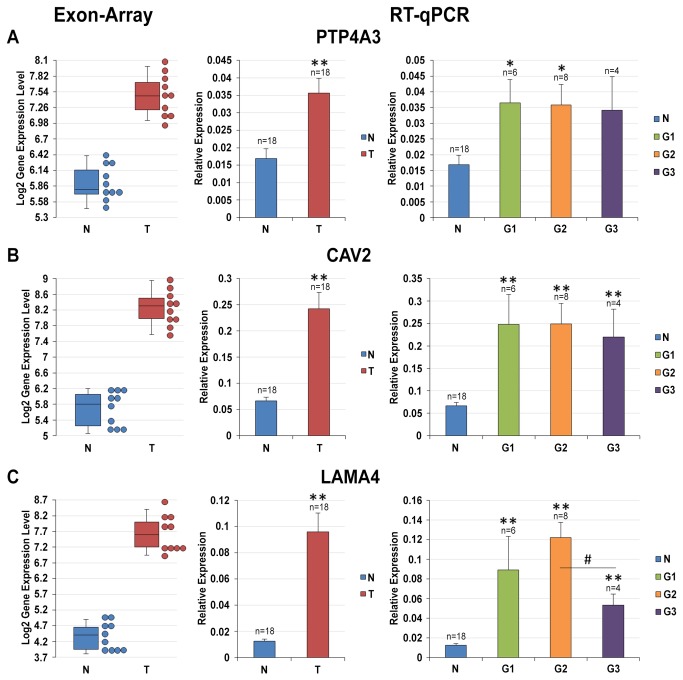
Gene Expression analysis of PTP4A3, CAV2 and LAMA4 genes.Expression levels of PTP4A3 (A), CAV2 (B) and LAMA4 (C) genes were calculated relative to the mean expression levels of ACTB and RPL13 genes. From left to right: box plot of log2 gene expression intensities resulting from microarray analysis (each dot stands for a sample); histogram of the expression levels (mean ± SE) of target genes in NT and ccRCC samples; histogram of the expression levels (mean ± SE) of target genes in NT and G1, G2 and G3 ccRCC samples. * = p-value < 0.05; # = p-value < 0.01; ** = p-value < 0.001.